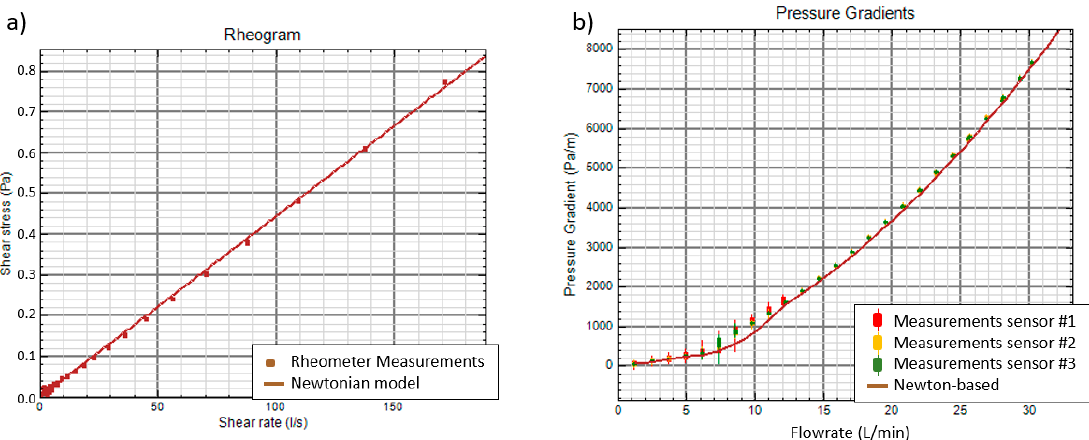
Figure 9. ( a ) Rheogram of the aqueous solution of glycerin (50 %vol) measured at 25 ◦ C with a scientific rheometer, ( b ) comparison between measured pressure gradients with the three di ff erential pressure sensors and pressure gradients calculated with a Newtonian rheological